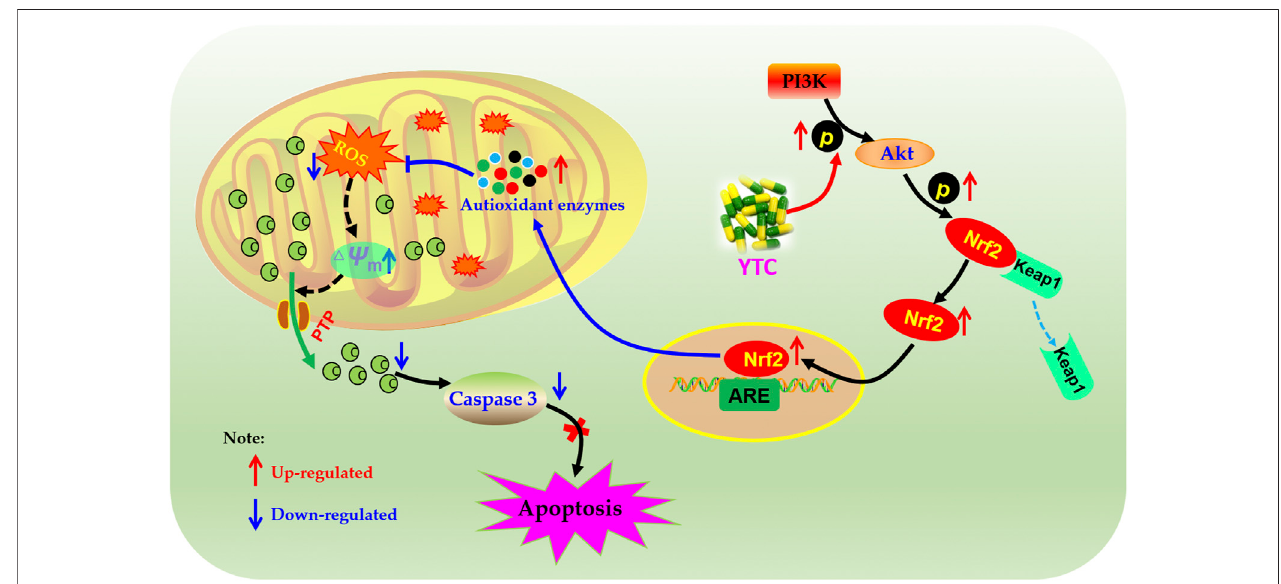
FIGURE 12 | Molecular mechanism of the protective effect of YTC. YTC possesses protective potentials on H 2 O 2 -stimulated H9c2 cells through suppression of oxidative stress-induced apoptosis via regulation of the PI3K/Akt/Nrf2 signal pathway.